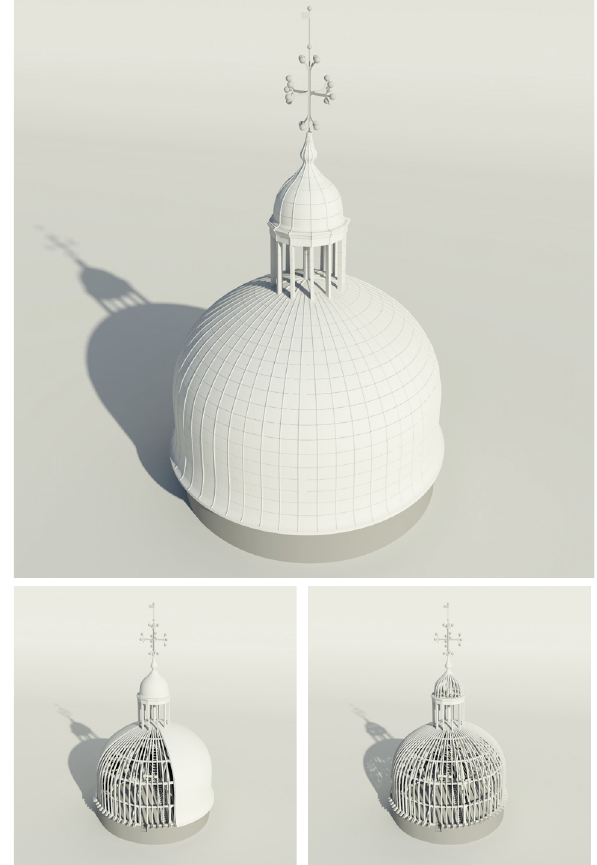
Figure 9. Images of the entire 3D model made with 3DStudioMax.